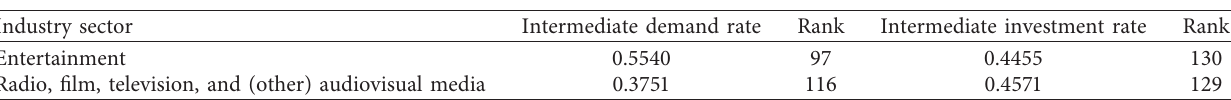
Table 3: Statistical table of intermediate demand rate and intermediate investment rate of the Chinese entertainment